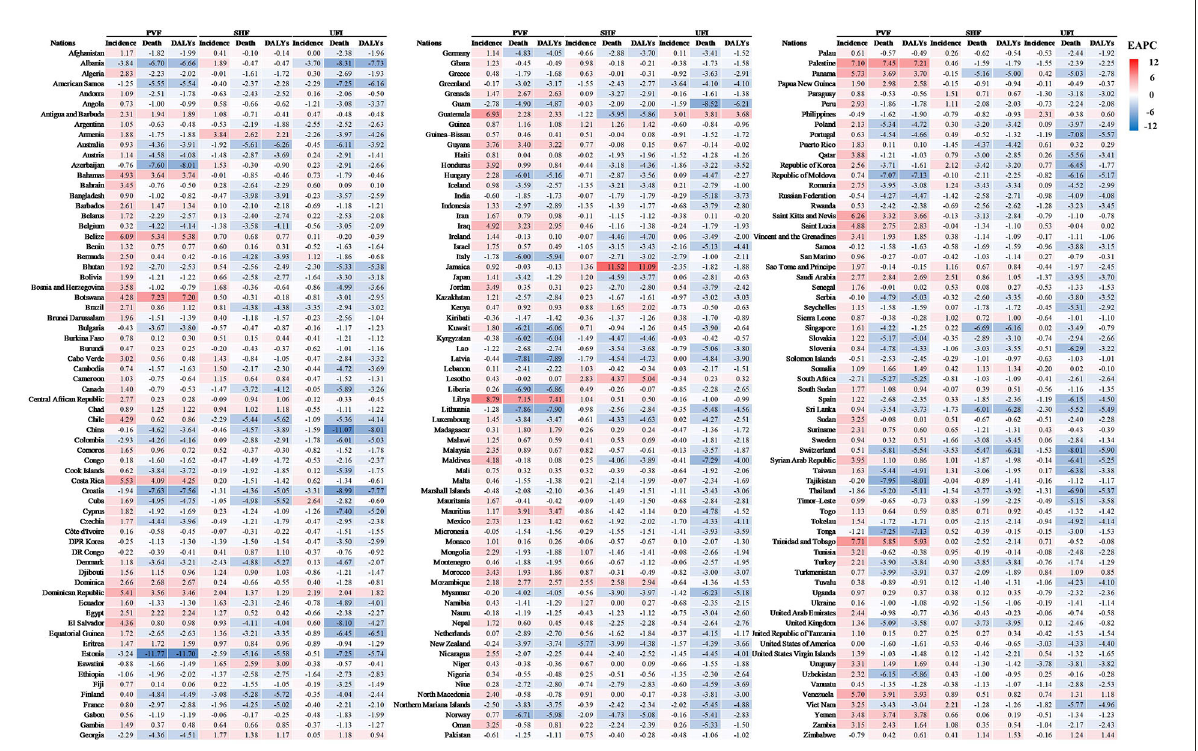
FIGURE2 The heatmap of EAPCs of incidence, death, and DALYs of PVF, SHF, and UFI at the national level. Red indicated higher value of EAPCs, while blue indicated lower one. PVF, physical violence; SHF, self-harm by firearm; UFI, unintentional firearm injuries; DALYs, disability-adjusted life years; EAPC, estimated annual percentage